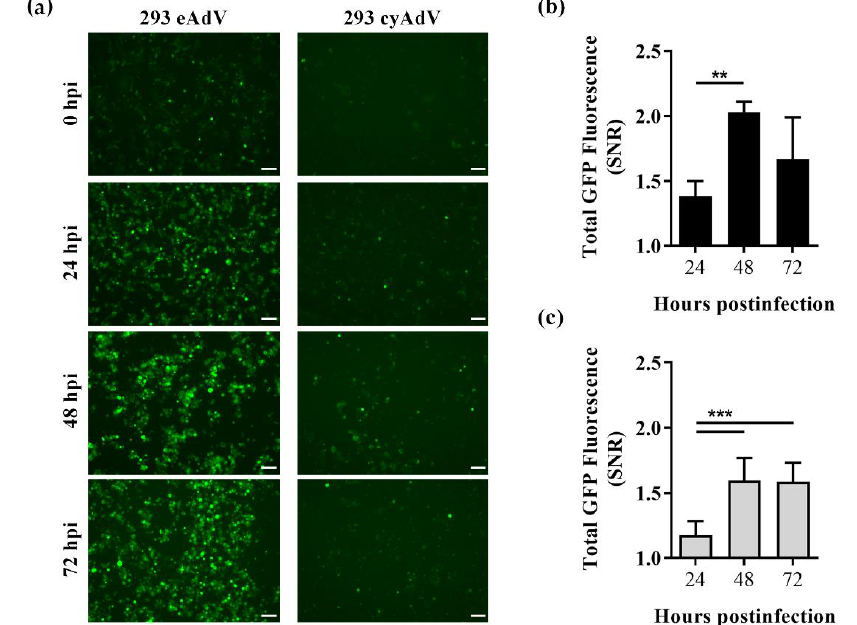
Figure 4. Characterization of whole cell biosensing platforms in response to adenoviral infection. 293 GFP10 cells stably expressing eAdV or cyAdV sensors were infected with adenoviral vectors at a multiplicity of infection of 5. At the indicated time points post-infection, sensor cells were ( a ) visualized by fluorescence microscopy, and GFP signal-to-noise ratio (SNR) was evaluated by flow cytometry for performance of ( b ) eAdV or ( c ) cyAdV sensors. Scale bar = 100 µm. Data shown as mean ± SD of at least three biological replicates. **, p < 0.01; ***, p < 0.001, as given by ANOVA followed by Tukey’s post-hoc test.